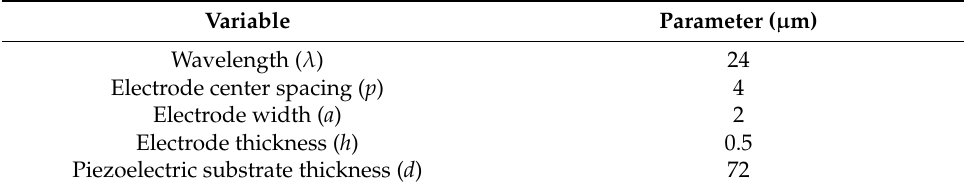
Table 1. Parameters of geometric model.